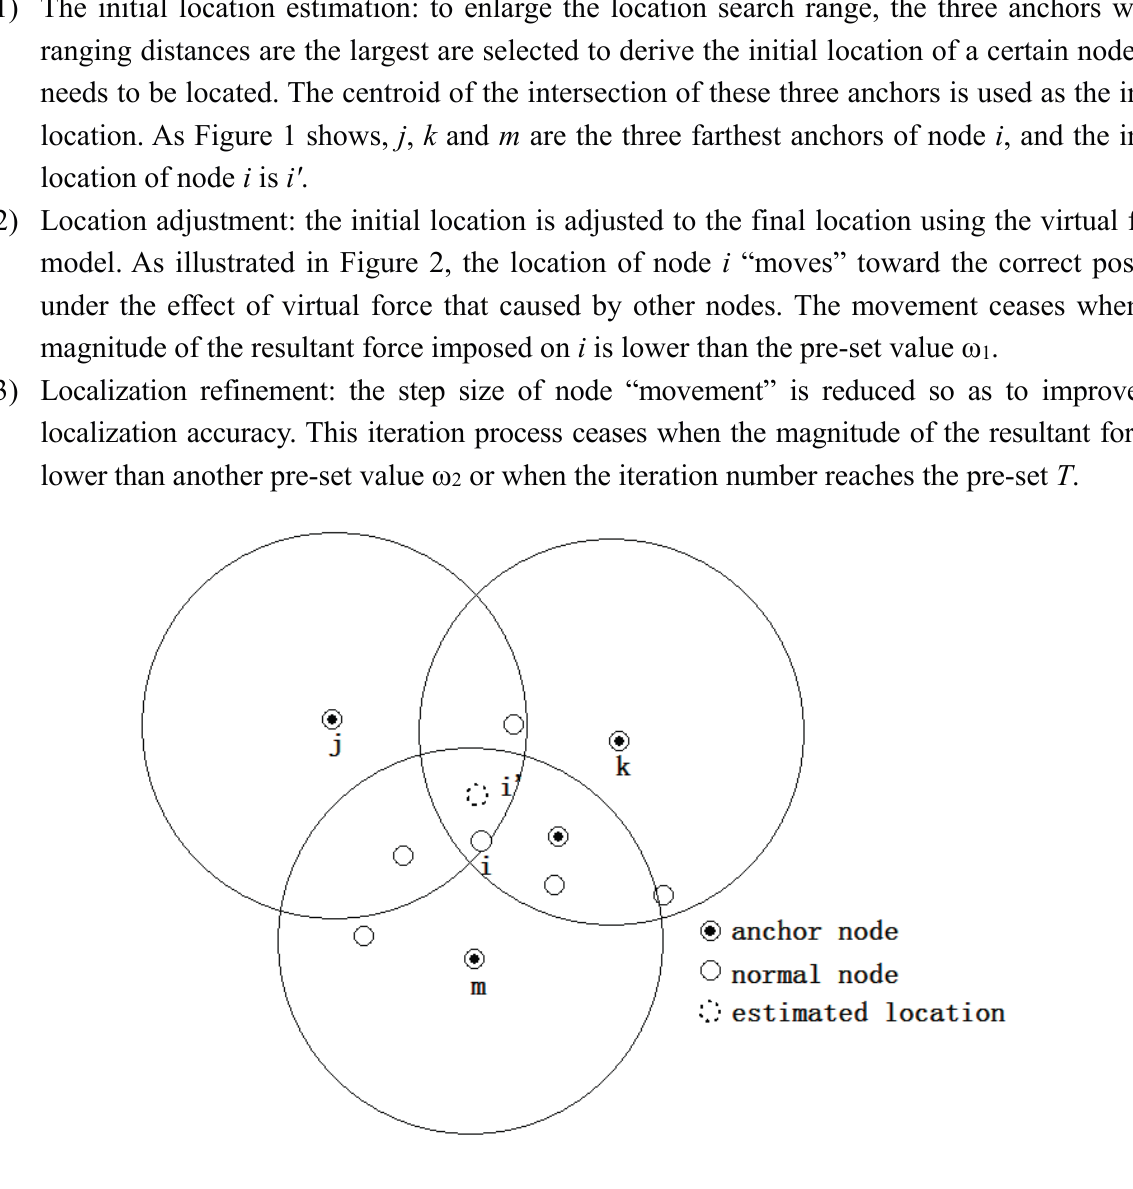
Figure 1. Initial location